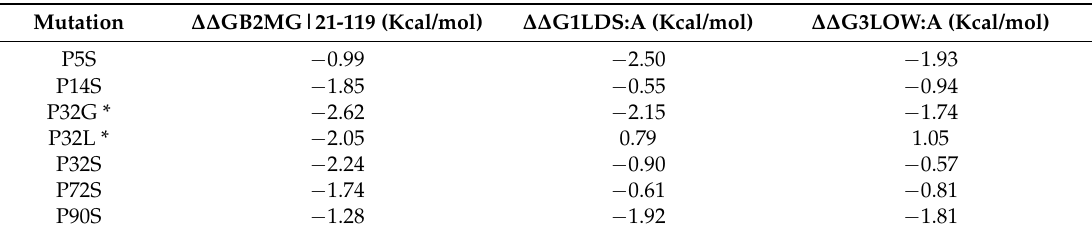
Table 2. Prediction of stability of human β 2 -microglobulin proline